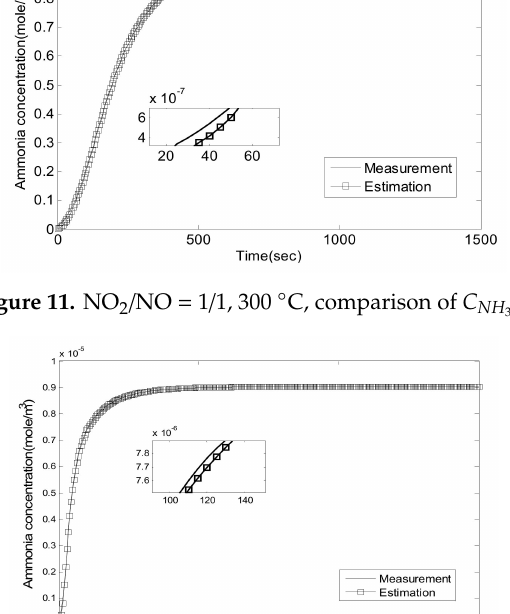
Figure 12. NO 2 / NO = 1 / 1, 350 ◦ C, comparison of C NH